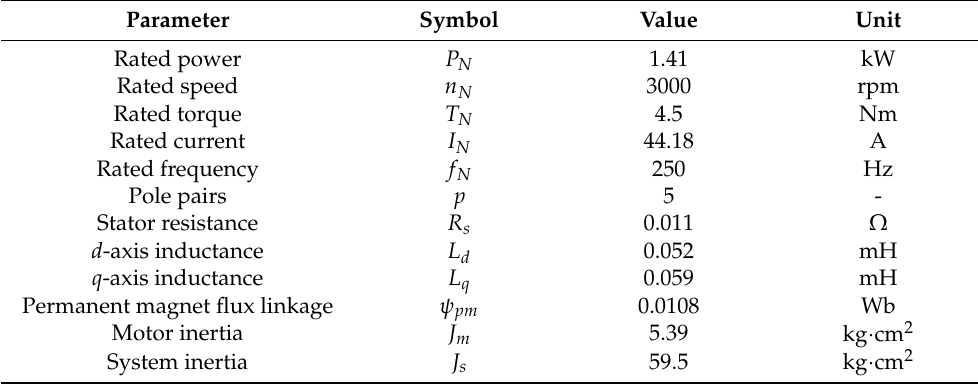
Table A2. Parameters of PMSM.